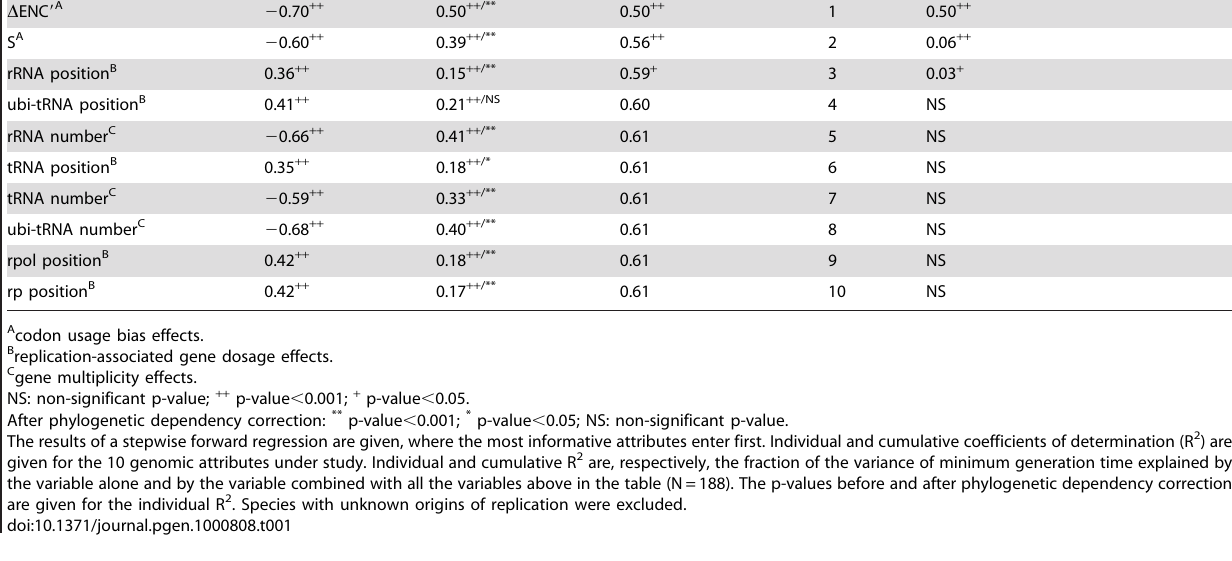
Table 1. Most informative attributes for the prediction of minimum generation time.